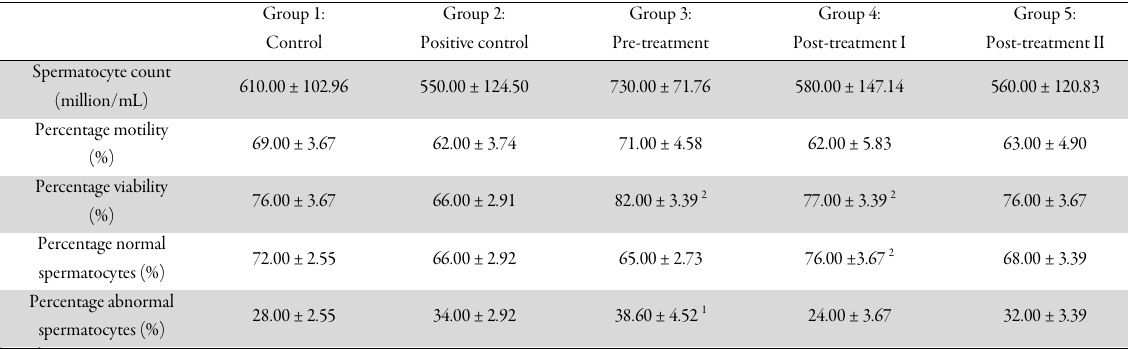
Table 3. Effect of aqueous leaf extract of Moringa oleifera on sperm parameters